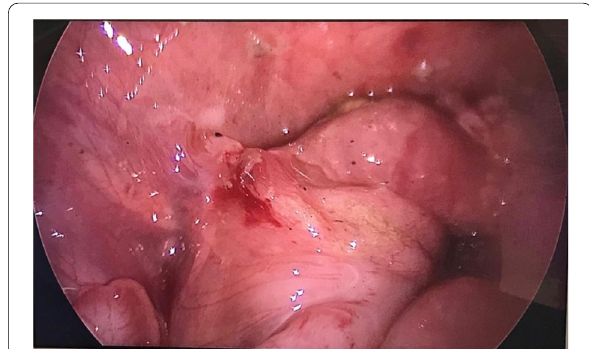
Fig. 1 Showing an example of intraoperative laparoscopic findings of bowel (cecal) inflammation and perforation in a patient with ALL on chemotherapy who presented with severe abdominal pain and findings of free air in the abdomen on CT